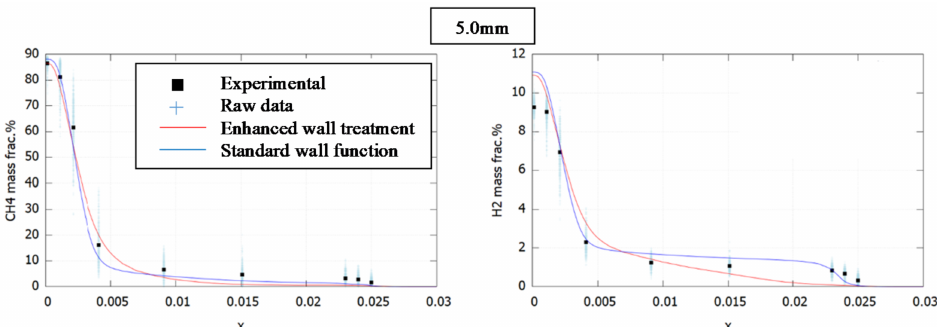
Figure 9. Fuel species mass fraction profiles at a 5.0-mm axial distance. SAGE/GRI-Mech 3.0. Complete experimental data available at reference